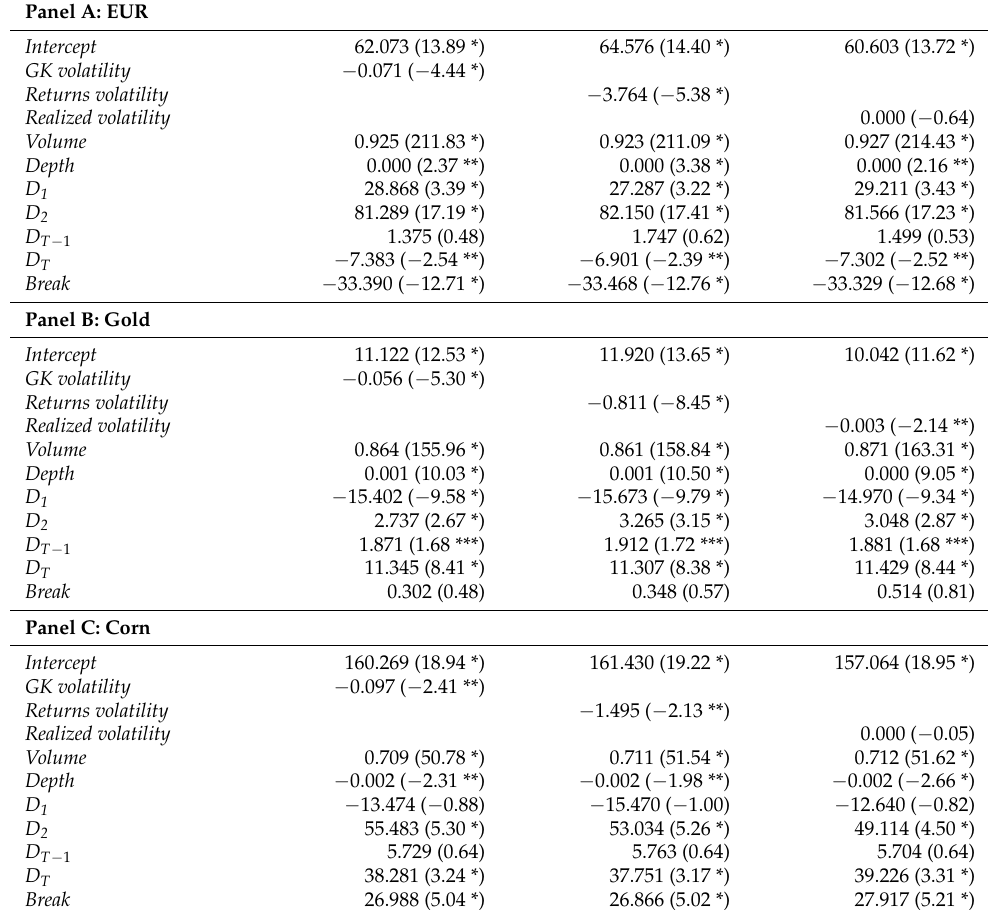
Table 6. Depth quantity and structural breaks. This table presents the coefficient estimates for